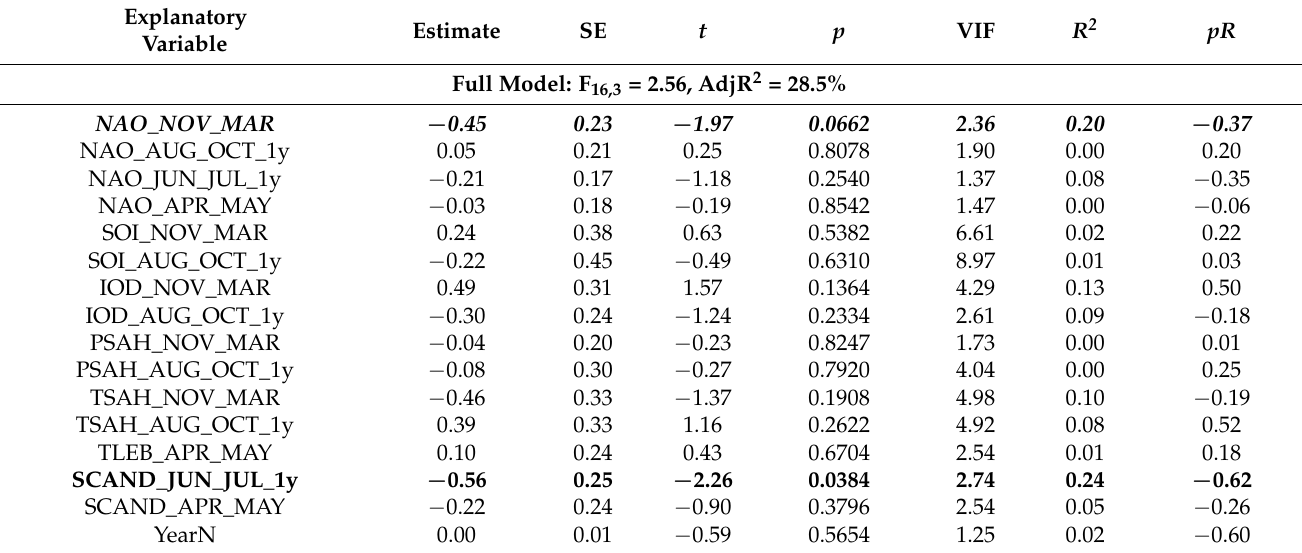
Table A7. Relationships between 15 climate variables and year in full models and Annual Anomaly of the timing of spring migration for the Pied Flycatcher Ficedula hypoleuca trochilus caught at Bukowo, Poland, in 1982–2021. Symbols as in Tables 1 and A5. p < 0.05 marked in bold face, 0.05 < p < 0.1 in bold italics .